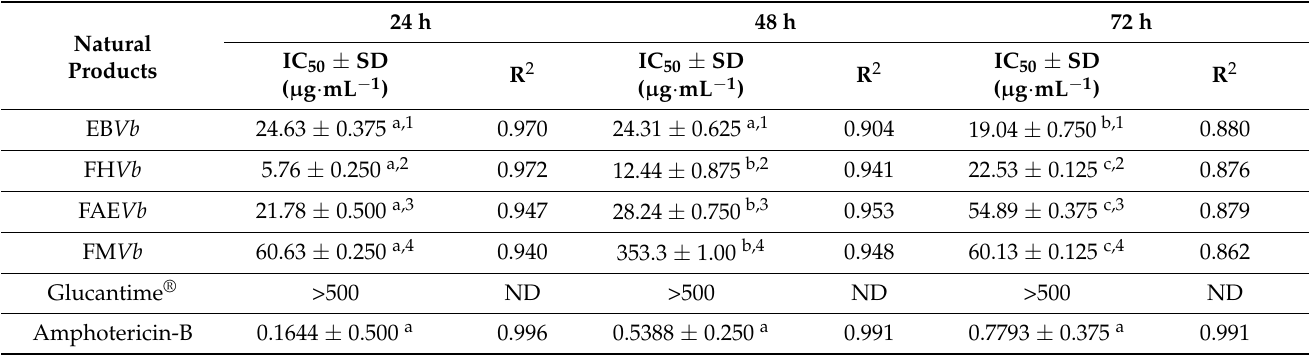
Table 3. Leishmanicidal activity of the crude extract and fractions of Vernonanthura brasiliana (L.) H. Rob against the promastigote forms of Leishmania amazonensis at three treatment times.